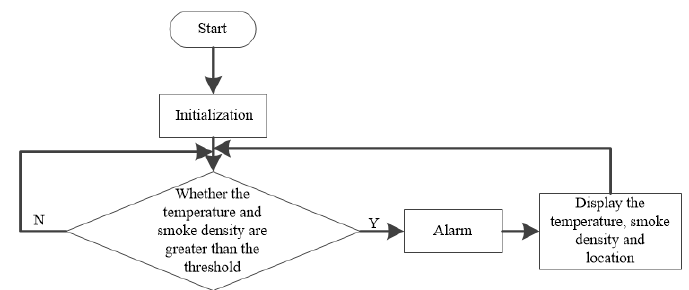
Fig. 12 . The software flow chart of the display